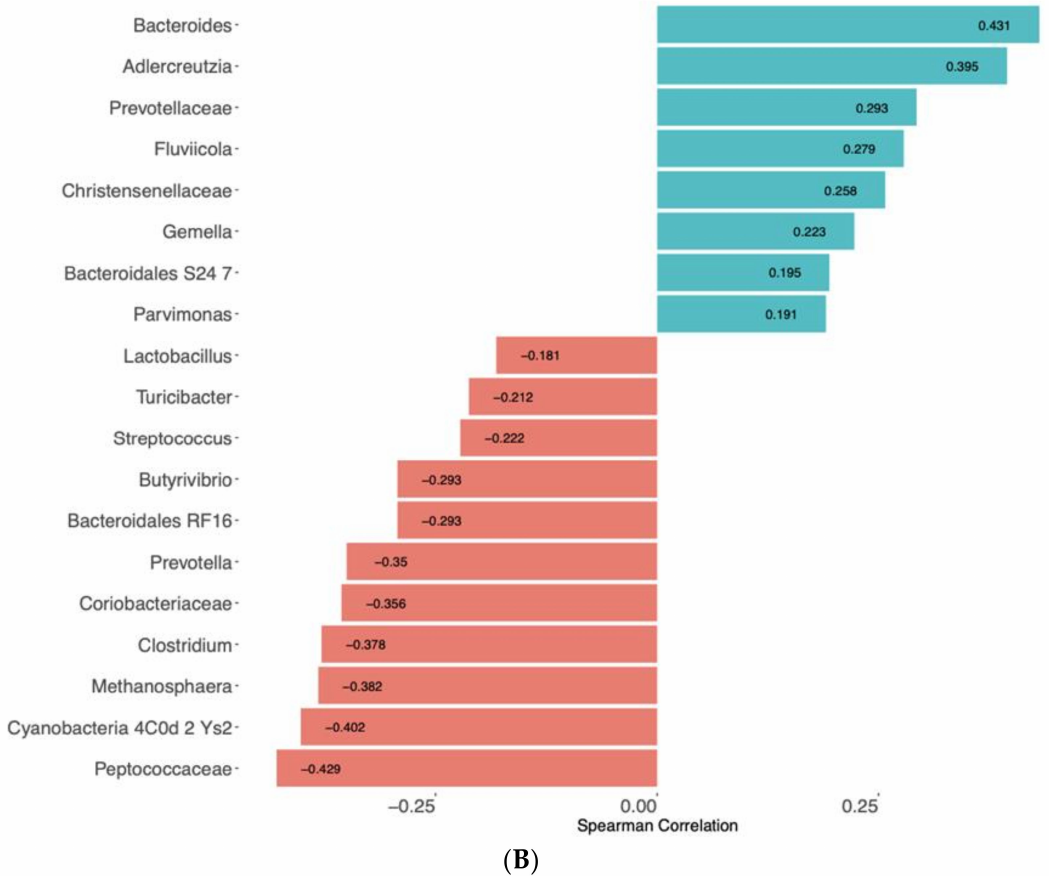
Figure 4. Spearman correlation between changes in clinical parameters and bacterial genera. ( A ). Number of anal gas evacuations. ( B ). Sensation of flatulence. Strength and significance of Spearman correlations (rho coefficient) are indicated in the colour shade. Red: change in microbiota genera negatively associated with the change in clinical parameter. Blue: change in microbiota genera positively associated with the change in clinical parameter. Only the highest correlations are